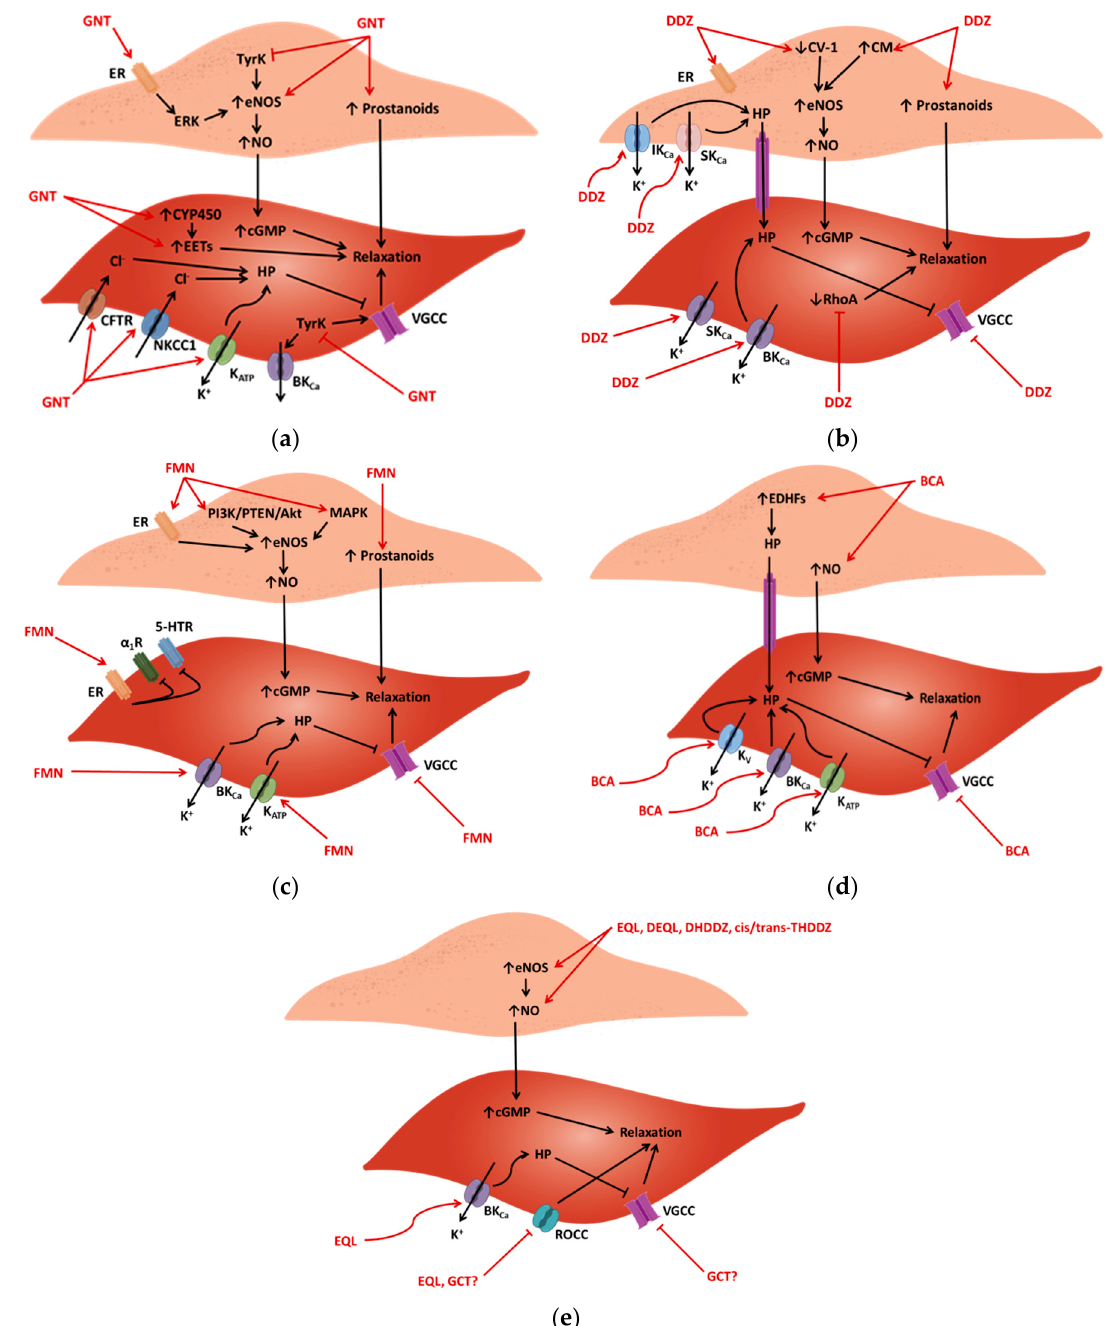
Figure 2 . ( a ) Proposed vasorelaxation mechanisms for genistein (GNT); ( b ) proposed vasorelaxation mechanisms for daidzein (DDZ); ( c ) proposed vasorelaxation mechanisms for formononetin (FMN); ( d ) proposed vasorelaxation mechanisms for biochanin A (BCA); ( e ) proposed vasorelaxation mechanisms for glycitein (GCT), equol (EQL), dehydroequol (DEQL), dihydrodaidzein (DHDDZ), and cis- and trans-tetrahydrodaidzein (cis-/trans-THDDZ). 5-HTR—serotonin receptor; α 1 R— alpha-1 adrenergic receptor; cGMP—cyclic guanosine monophosphate; CFTR—cystic fibrosis transmembrane